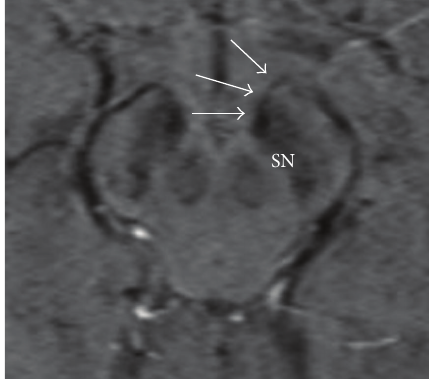
Figure 2: The FN (delineated by white arrows) is shown at its junction with the SN (SWI, 2